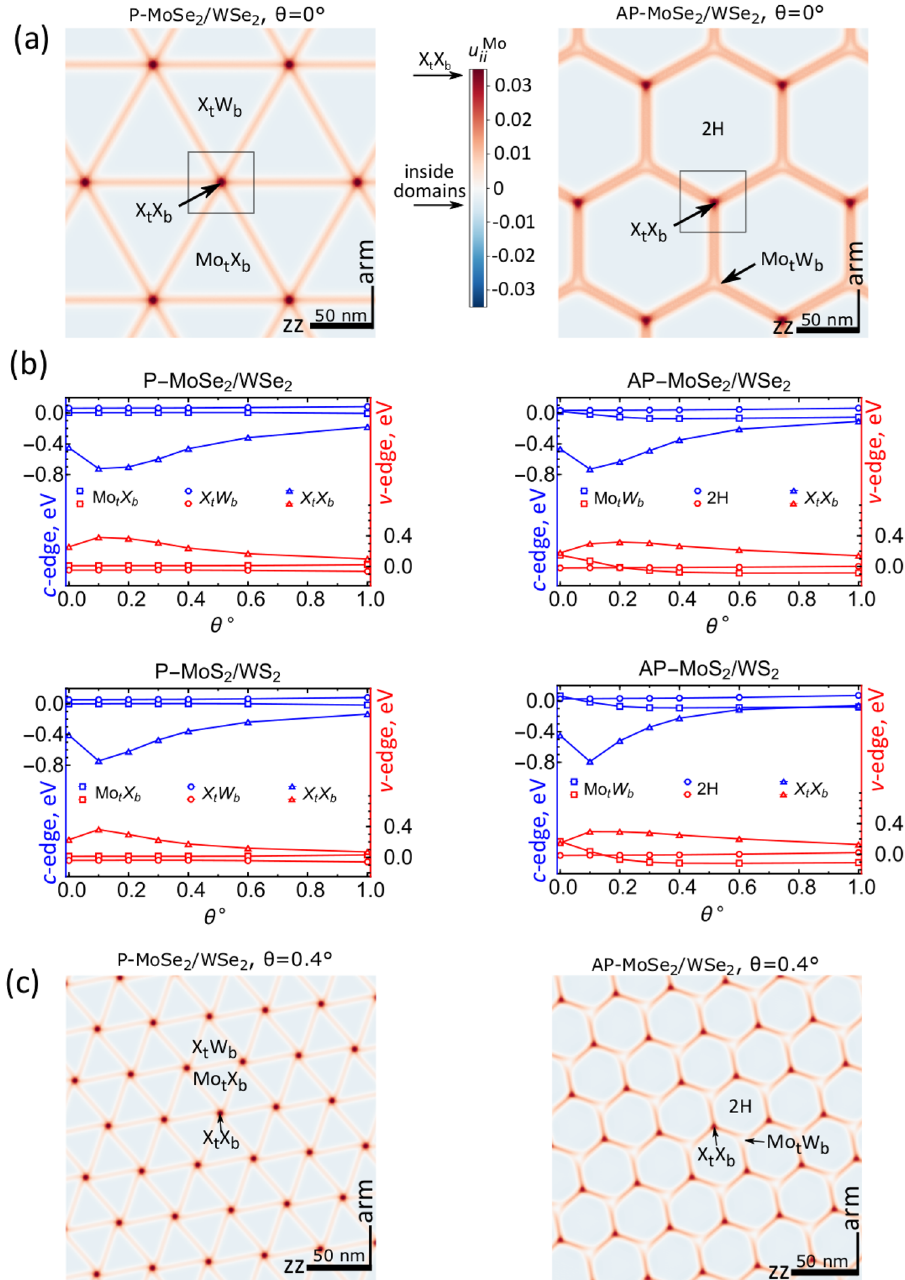
Fig. 2 Lattice reconstruction and local conduction and valence band edge modulations at K-valleys in twisted MoX 2 /WX 2 bilayers. a and c Show distribution of the hydrostatic strain, u Mo ii , in MoSe 2 layer of P- and AP-MoSe 2 /WSe 2 bilayers with θ = 0° and θ = 0.4°, respectively. Squares in ( a ) show areas used to plot band edge pro fi le in Fig. 3. Arrows on the scalebar indicate the values of u Mo ii inside domains and at NoDW nodes. b Modulations of conduction ( c ) and valence ( v ) band edges as a function of twist angle for high symmetry stackings of moiré supercell, indicated by different symbols, for P/AP- MoSe 2 /WSe 2 and MoS 2 /WS 2 bilayers. Matching MoX 2 and WX 2 lattices inside the large area domains determines homogeneous strain which is accounted for through offsetting of MoX 2 and WX 2 strain axes in Fig.